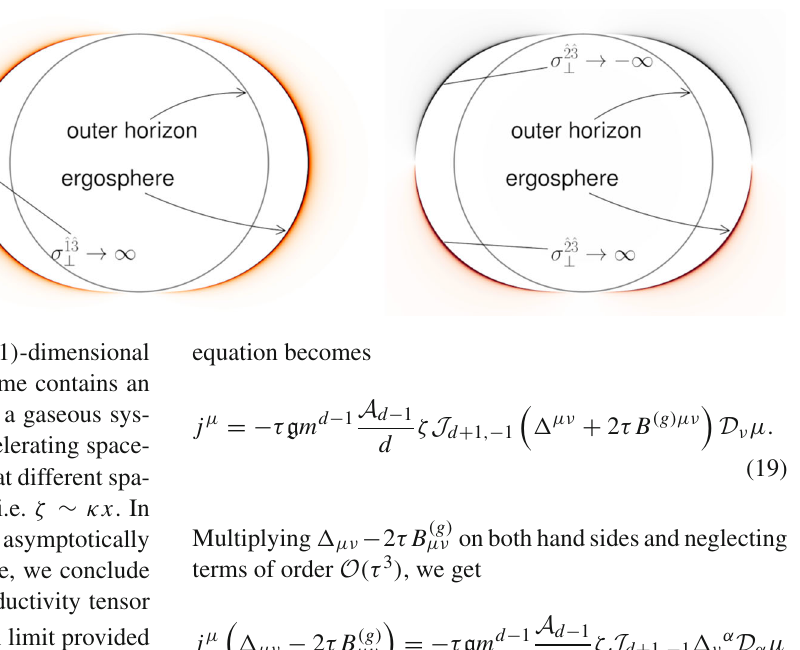
Fig. 1 σ colors represent bigger